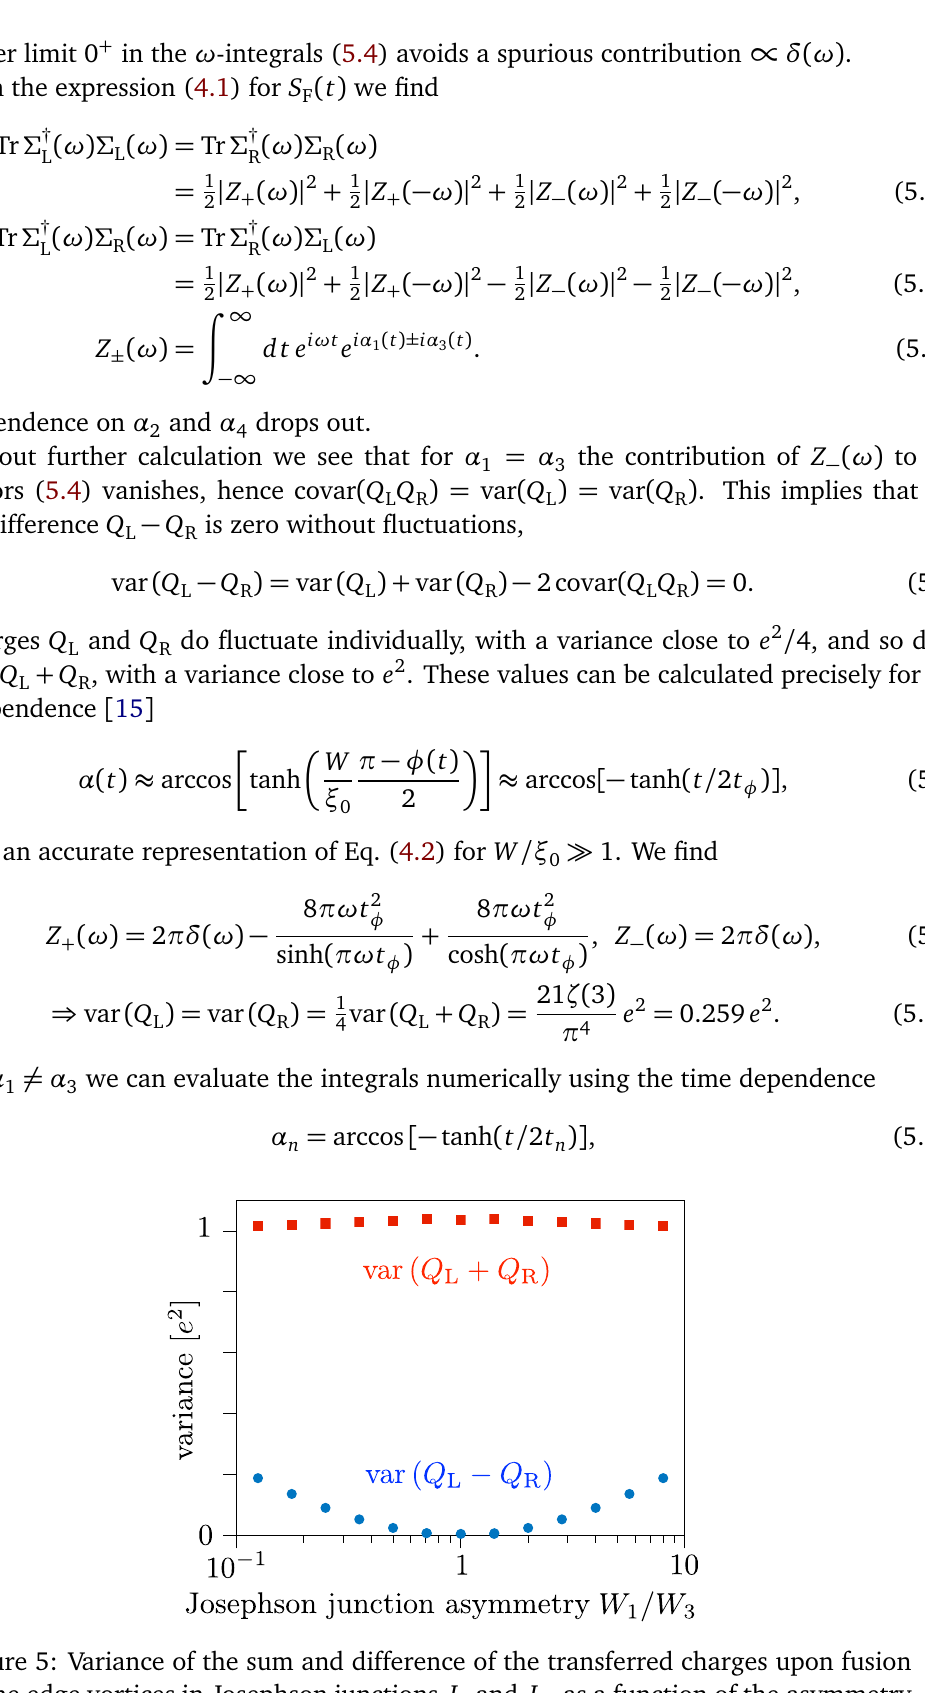
and J , as a function of the asymmetry 2 4 and J 1 3